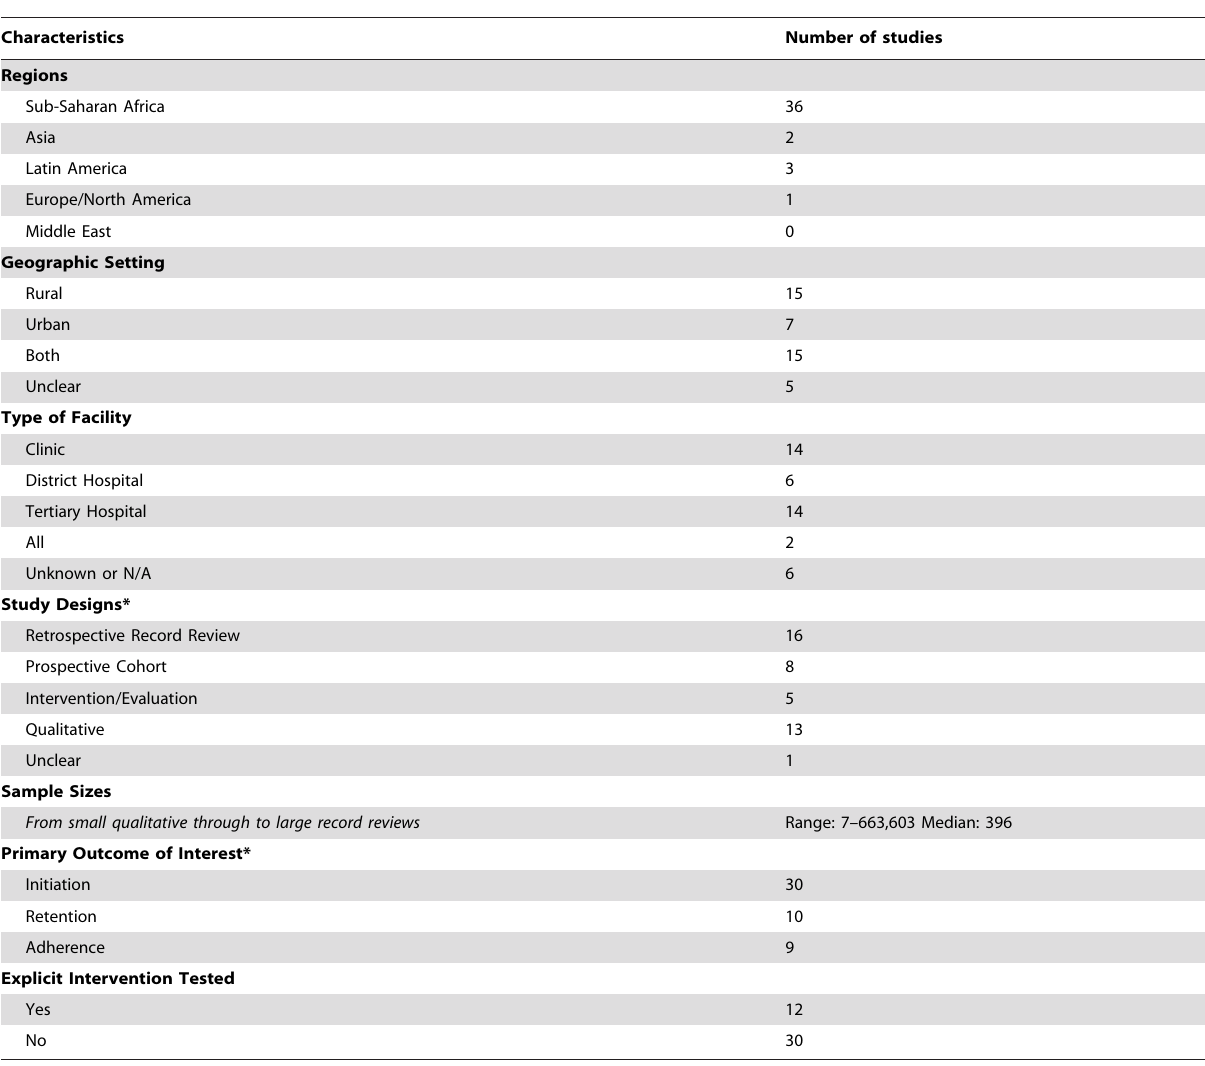
Table 1. Summary of Characteristics of Included